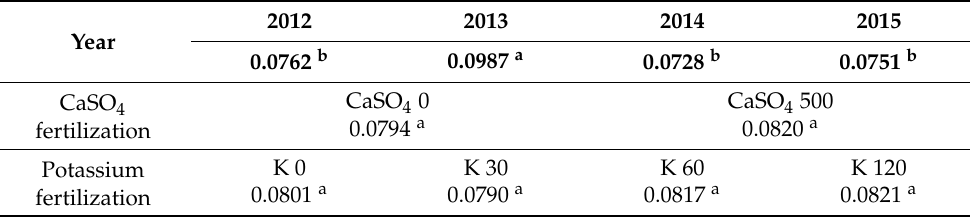
Table 6. Effect of analyzed factors on acid phosphatase activity ( µ mol pNP g − 1 DM of soil h − 1 ).